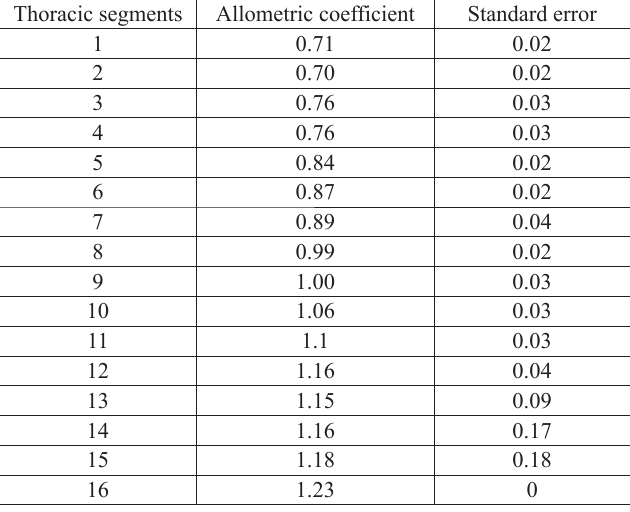
Table 2. Allometric coefficients and standard errors of the length of each thoracic segment relative to the trunk during the meraspid degrees 4–16 of Changaspis